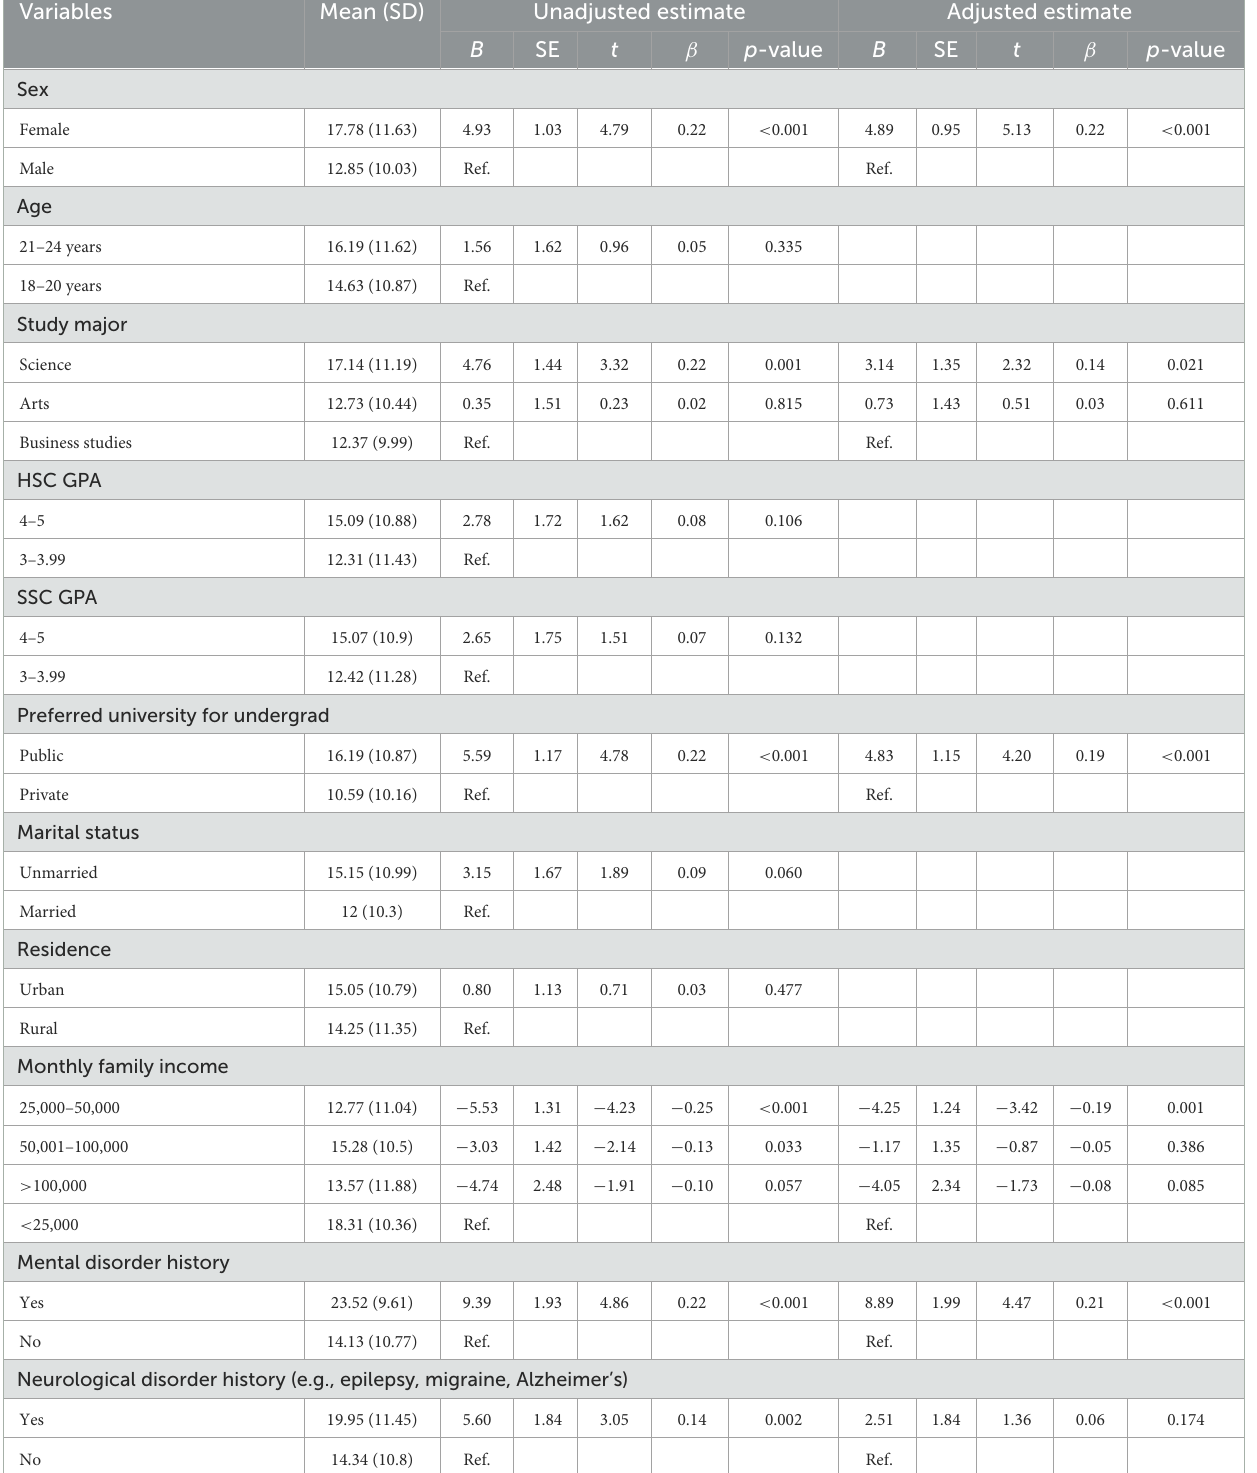
TABLE 4 Bivariate and multivariable regression analyses by stress score.